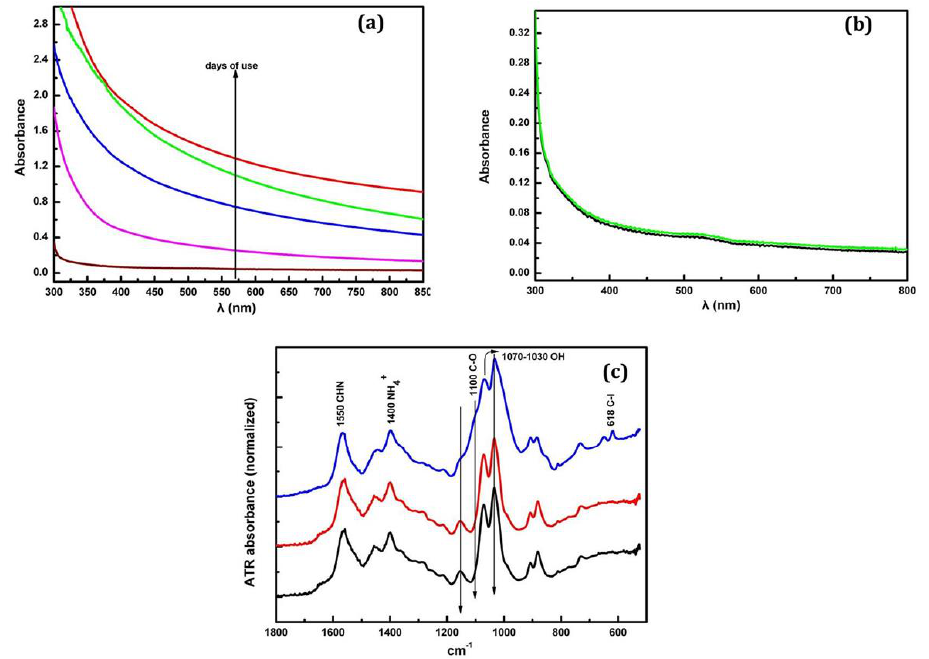
Figure 4. ( a ) Absorption spectrum of Castrol Syntilo 81 BF coolant over 28 days of use ( b ) comparison of the pure material (black) and after 28 days (green) absorption spectra and ( c ) ATR spectrum of coolant before use (black), after 7 days (red) and 21 days (blue) of use.